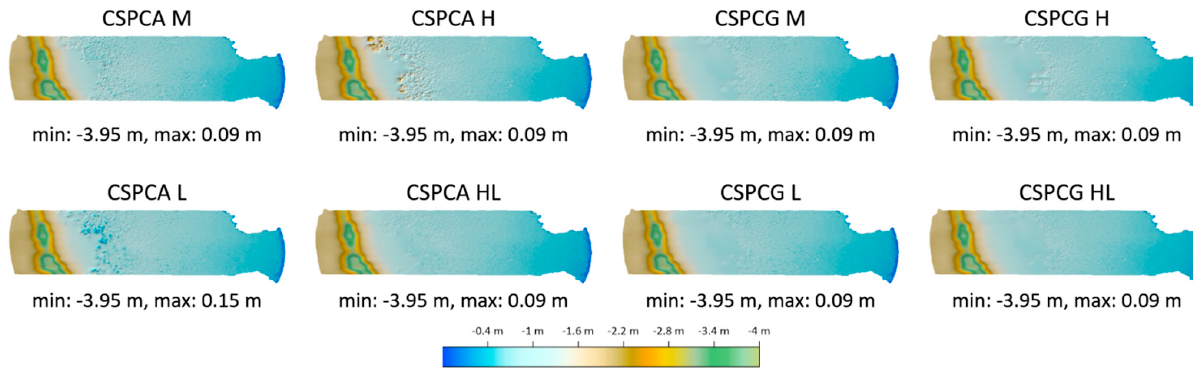
Figure 21. Models obtained by the inverse distance method.